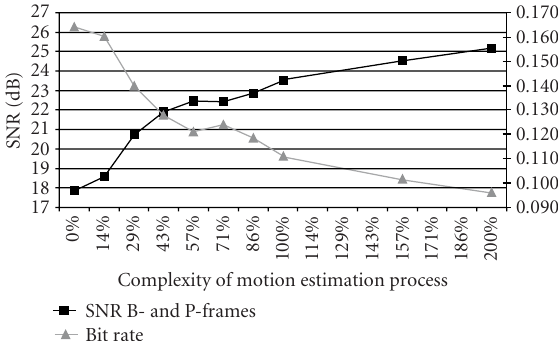
Figure 12: Average PSNR of motion-compensated P- and B-frames and the resulting bit rate of the encoded “Stefan” stream at di ff er- ent computational e ff orts. A lower average PSNR results in a higher di ff erential signal that must be coded, which leads to a higher bit rate. The percentage shows the di ff erent computational e ff ort that results from omitting the computation of vector fields in Stage 1 or performing an additional refinement in Stage